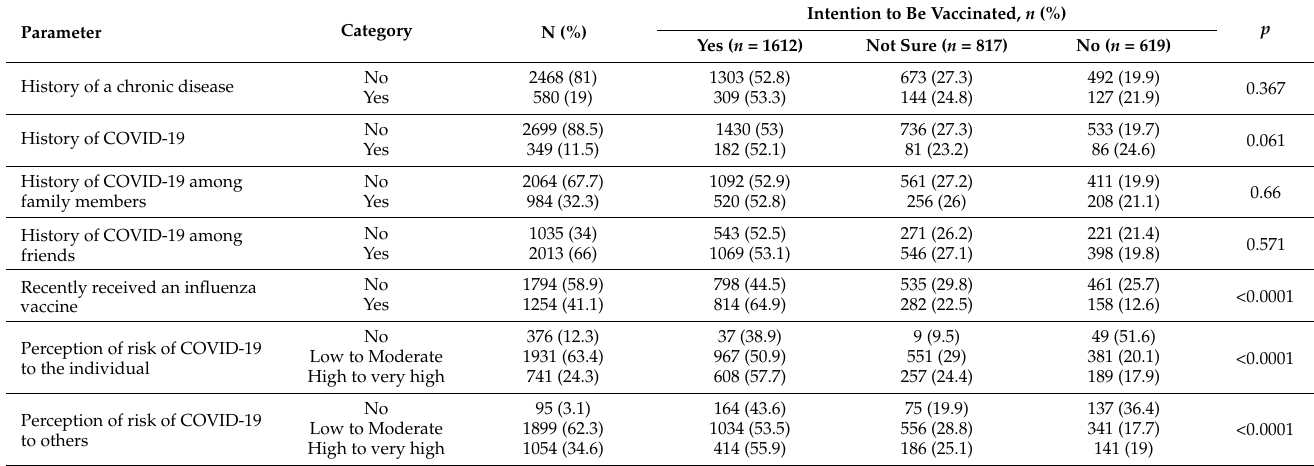
Table 2. Medical histories and experiences with COVID-19 among participants and their distribution by intention to be vaccinated ( n = 3048).